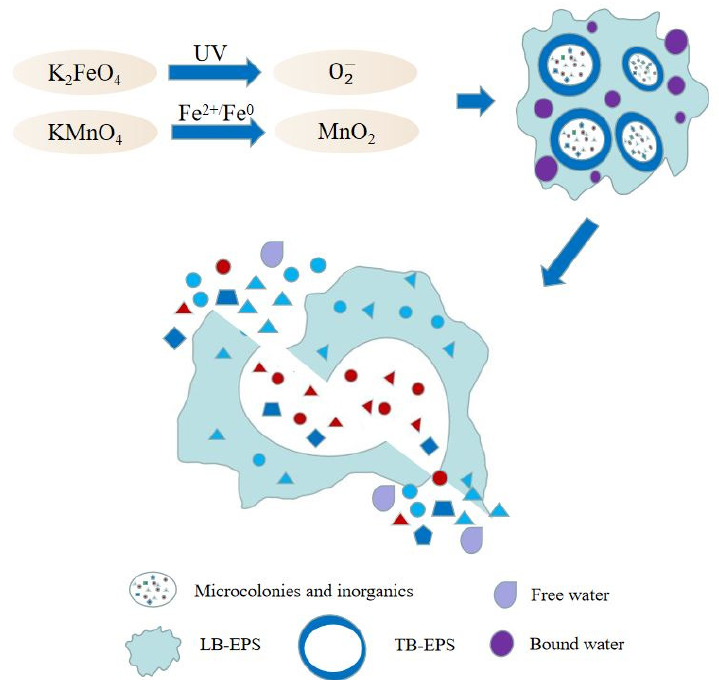
Figure 4. Mechanism of enhanced sludge dewatering by permanganate and ferrate pretreatment. Fe 2+ and ZVI have catalytic effects on potassium permanganate, and under the catal-